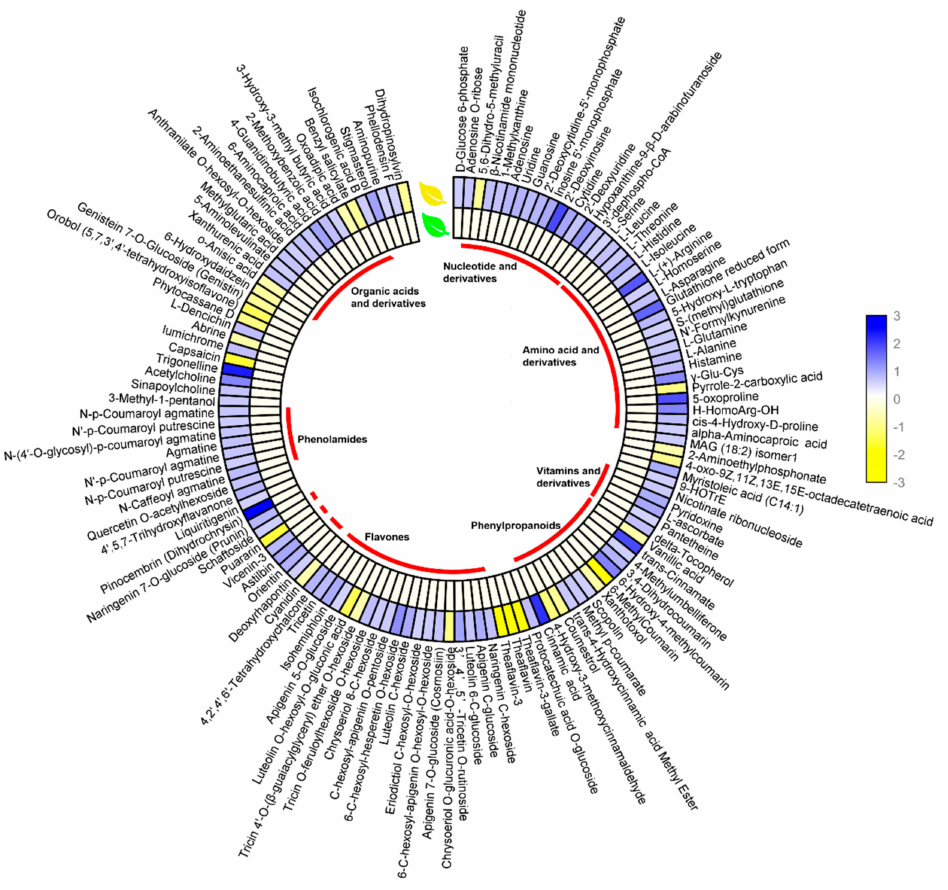
Figure 3. The heatmap of the fold changes of SCMs between the young shoots of YR and GR. The color bar represents the normalized fold change values. Six categories with elevated SCM levels are marked, including nucleotides and derivatives, amino acids and derivatives, vitamins and derivatives, phenylpropanoids, flavones, phenolamides, and organic acids and